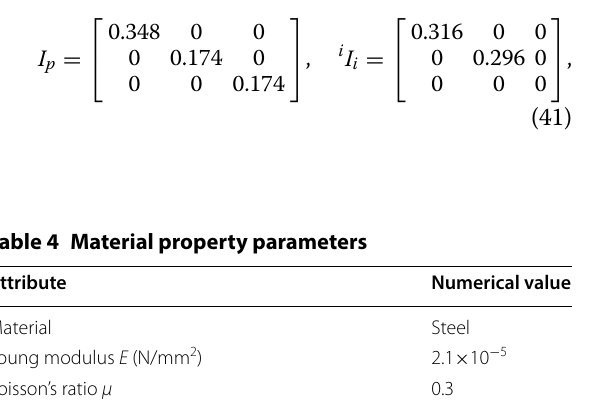
Figure 15 Motion angles for the hip in multiple gait